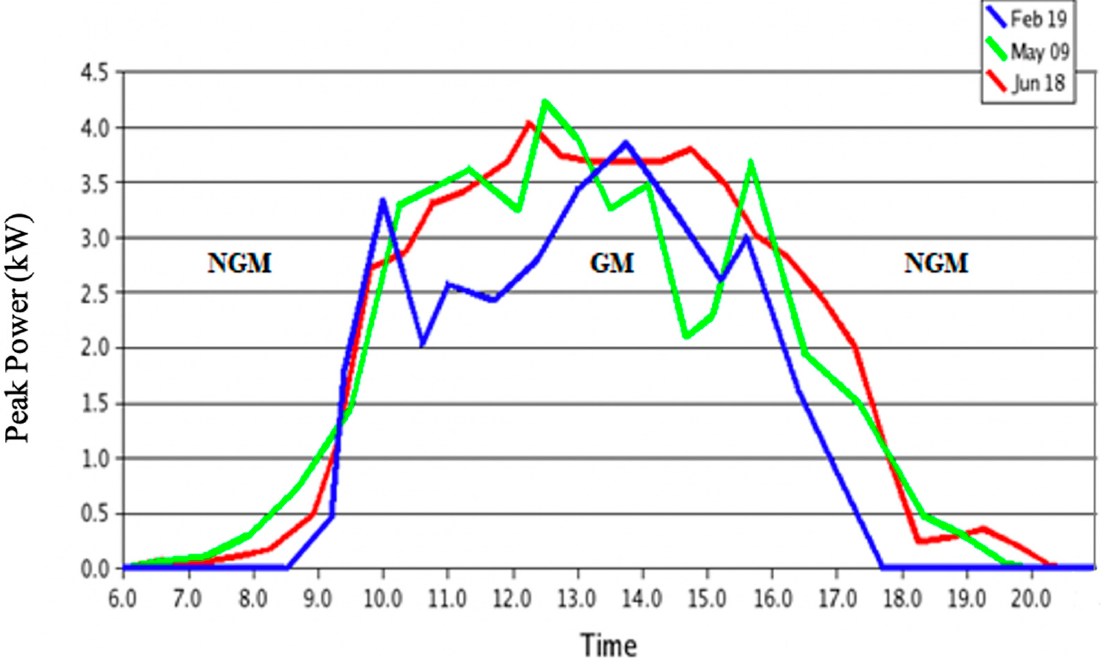
Figure 3. Hourly generation modes for solar PV.